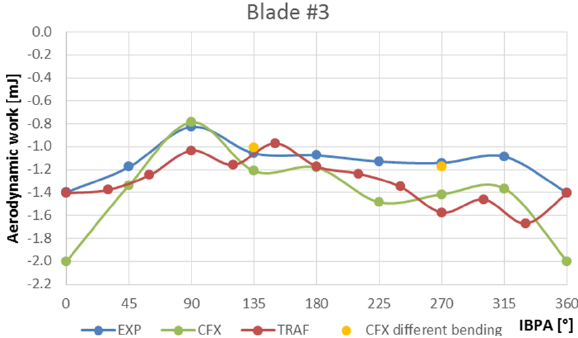
Figure 16. Aerodynamic work of blade bending motion - blade #4: experimental (EXP), CFX and TRAF comparison.